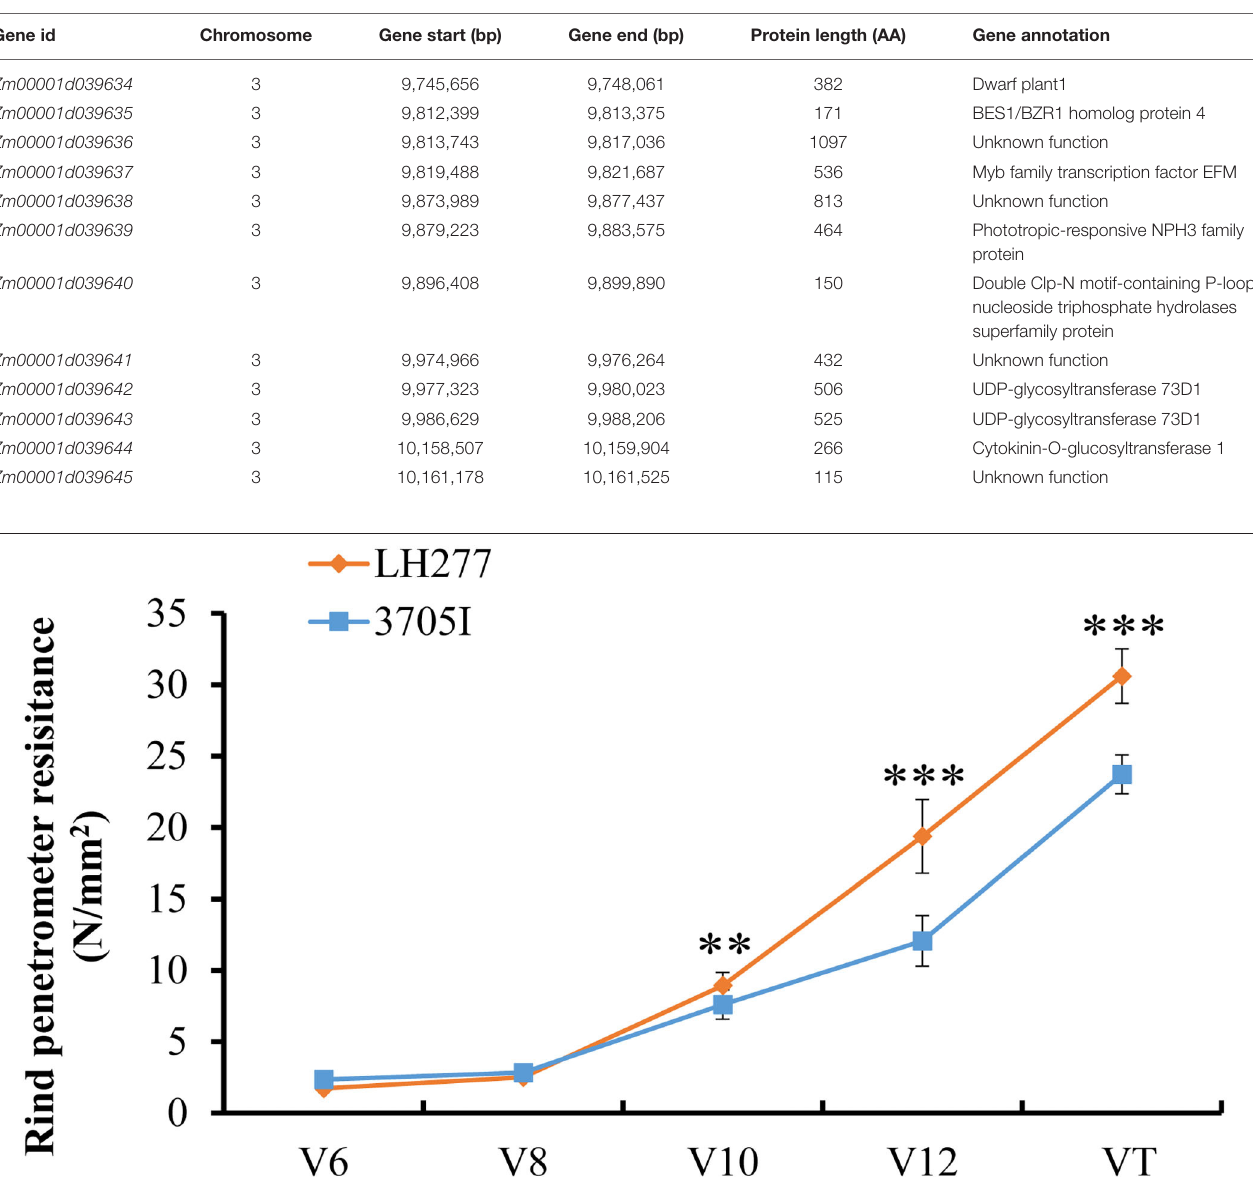
TABLE 3 | Candidate genes in the 550kb physical region of qRPR3-1 .